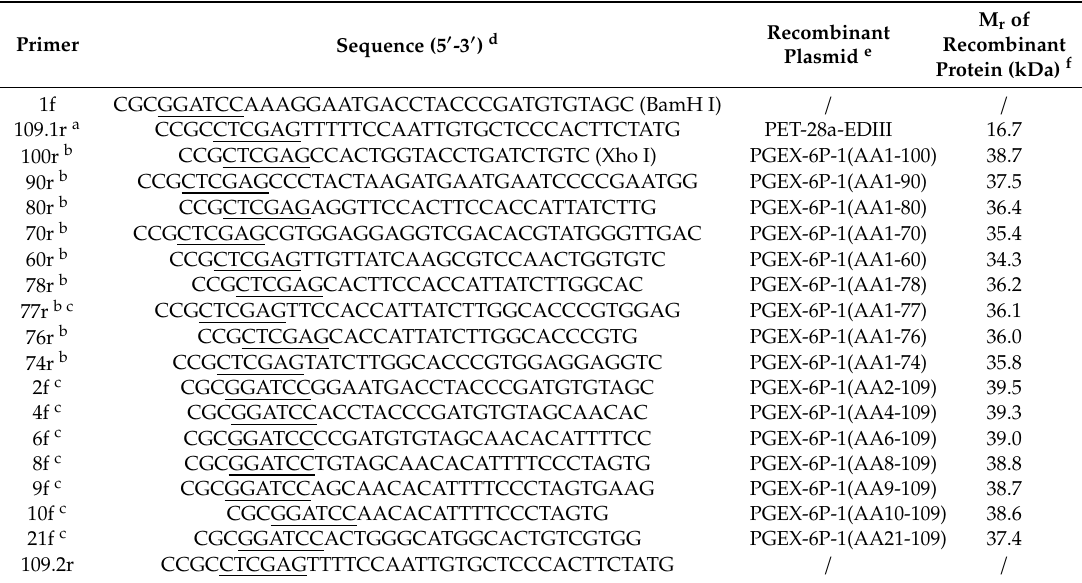
Table 1. Primers used for construction of recombinant plasmids expressing full-length EDIII protein and a series of truncated EDIII